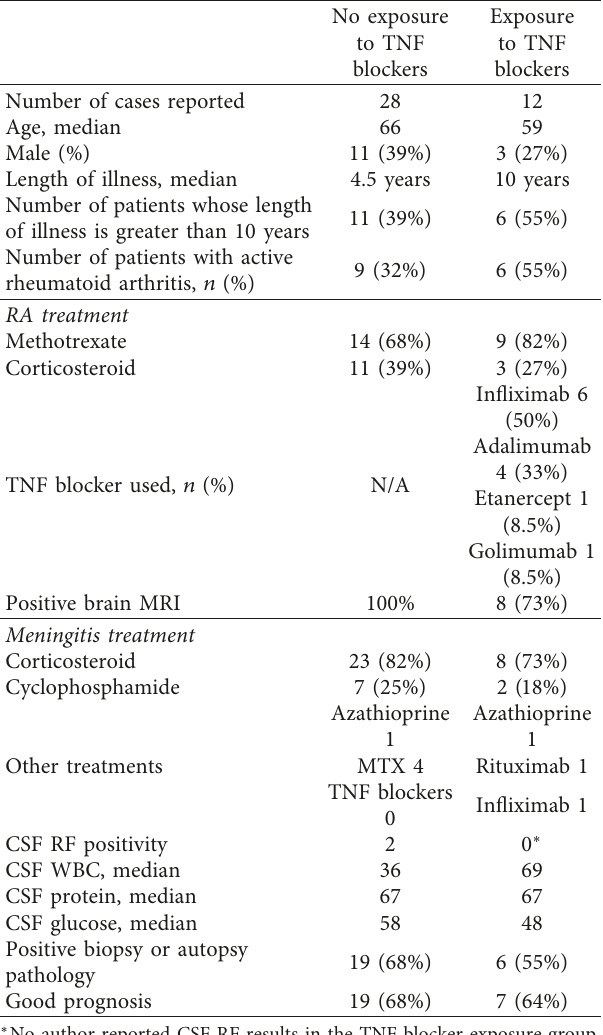
Table 1: Overview of patients with rheumatoid meningitis and